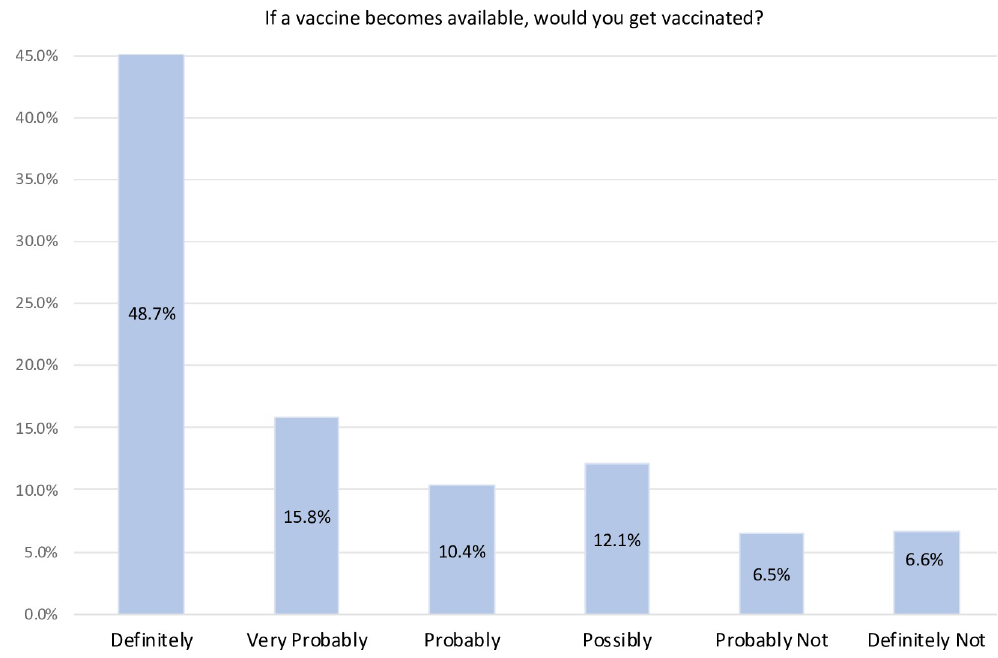
Fig 2. COVID-19 vaccine hesitancy distribution in the United States and Canada (n = 7678).